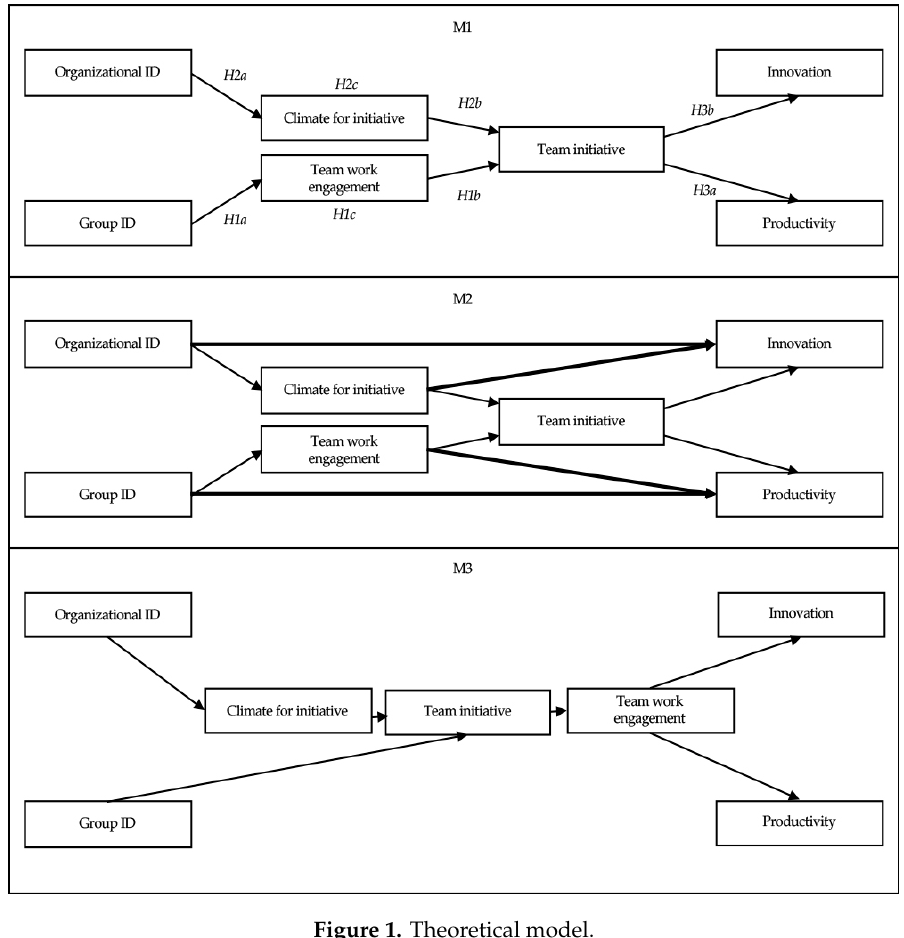
Figure 1. Theoretical model